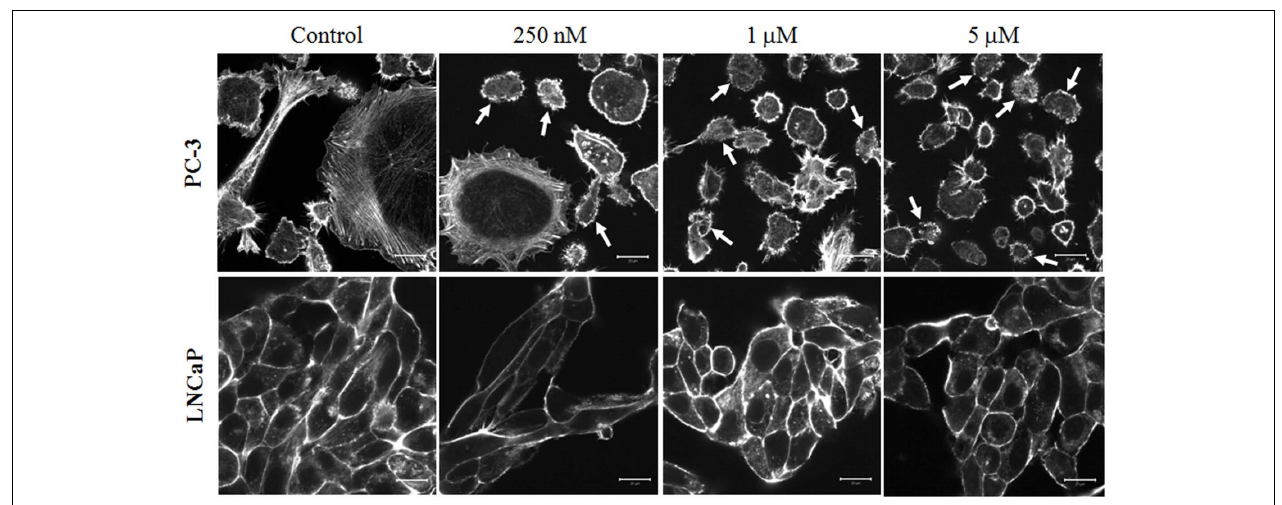
presenting strong actin disruption or blebbing are highlighted by arrows. LNCaP cells treated with 250nM, 1 μ M, and 5 μ M concentrations of 17e showing no actin disruption when compared to